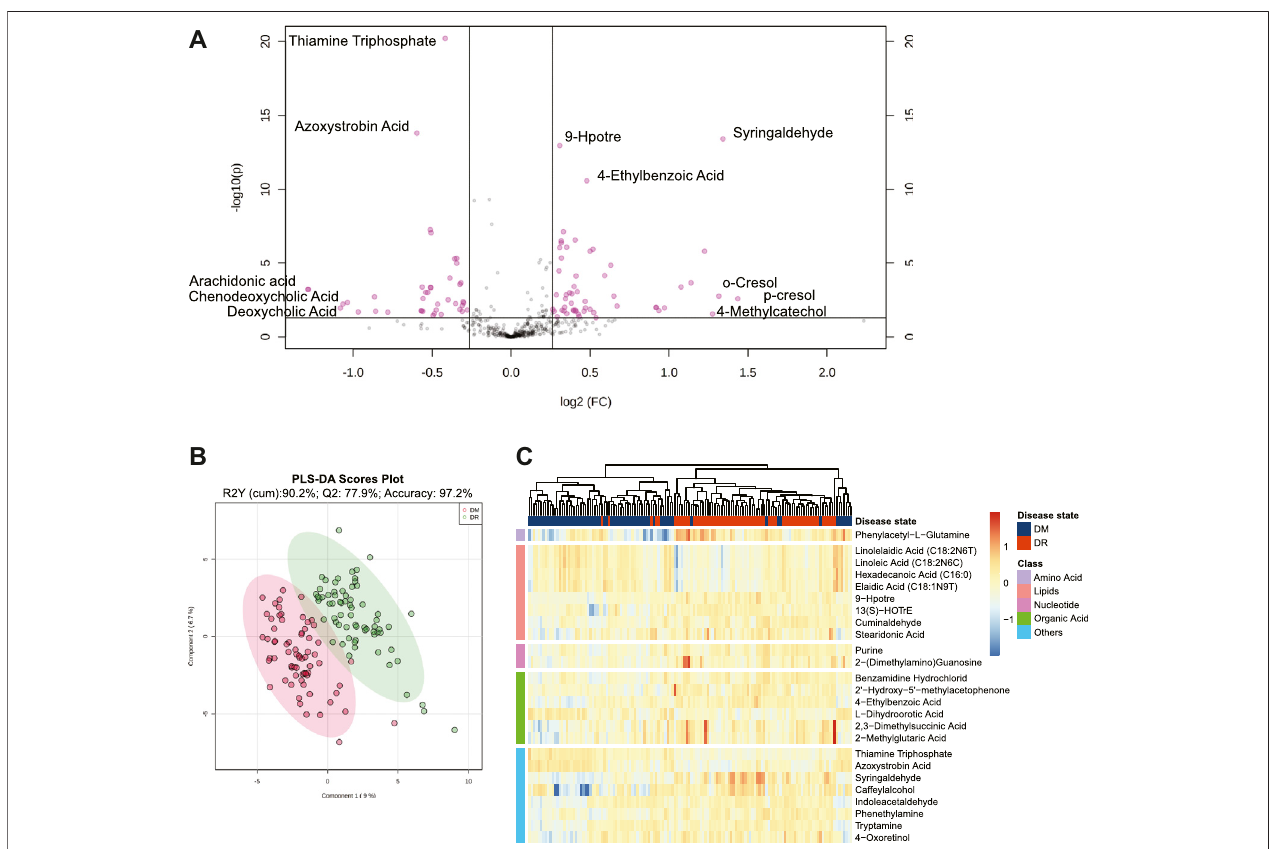
FIGURE 1 | (A) Volcano plot of metabolites between DM and DR patients (FDR < 0.05; fold changes > 1.2 or < 0.8). (B) PLS-DA score plot. The model was established using three principal components. Cumulative R2 archived 90.2%, Q2 achieved 77.9%, and accuracy achieved 97.2% with permutation test p -values less than0.001. (C) Heatmap forintensitiesoftop25differentiallyexpressed metabolitesbetweenDMandDRpatientswiththesmallestpaired t -testFDR q value.Euclidean distance metric and Ward ’ s clustering method were applied for the hierarchical clustering. Red represents increased intensities and blue decreased